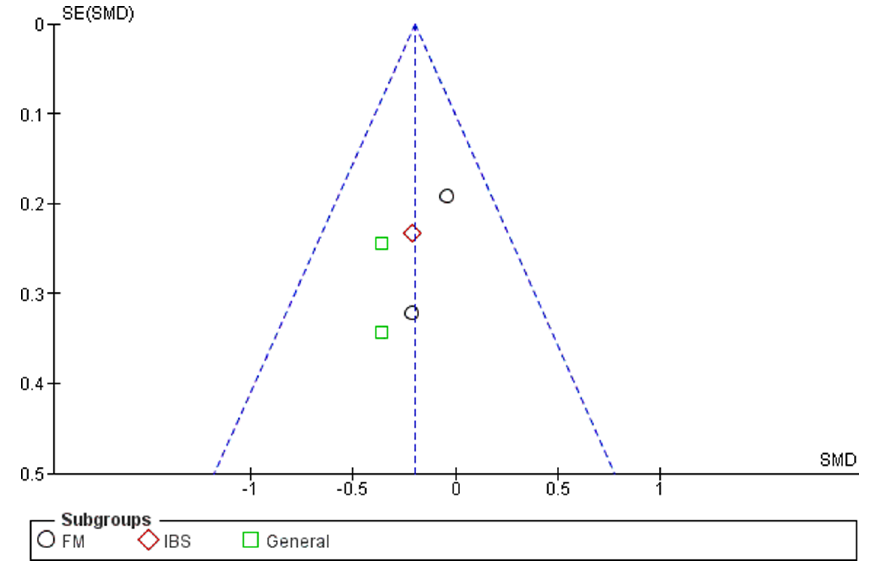
Figure 6. Funnel plot for anxiety.